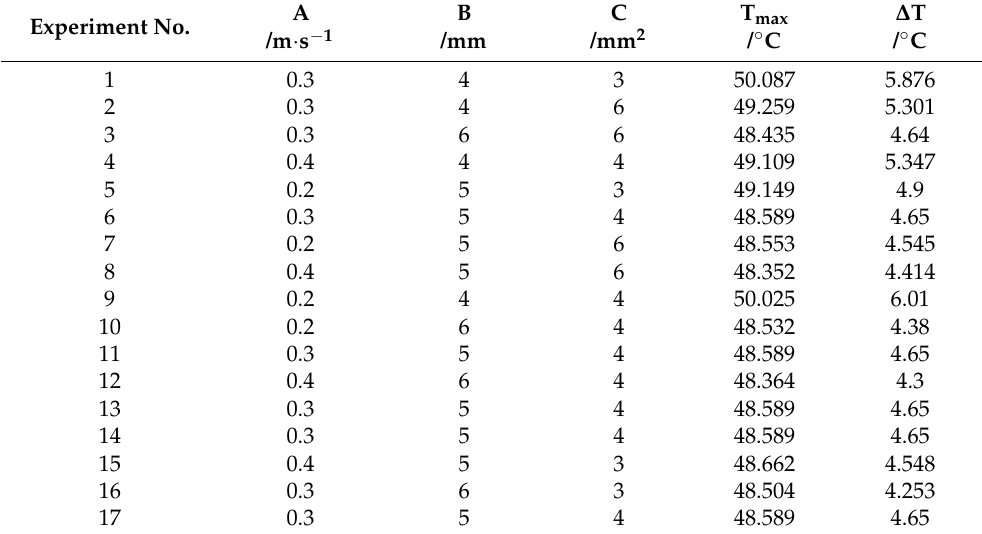
Table 2. Experiment design and